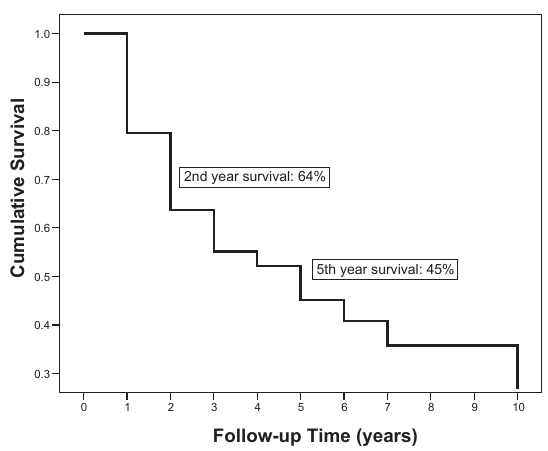
Figure 1 - Overall survival curve for patients with DLBCL of the OC-MR, seen at the A.C. Camargo Hospital for Cancer, between January 1980 and December 2005.